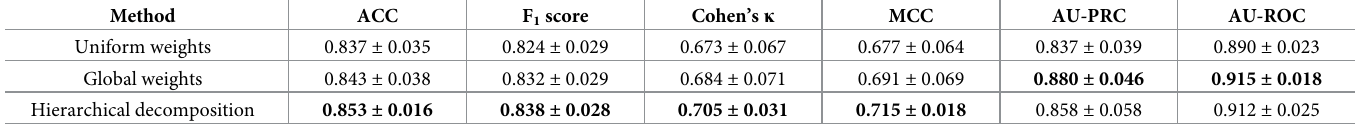
Table 5. Nested cross-validation (outer folds) model performance estimates for each multi-kernel learning method. Uniform weights correspond to the sum of kernel matrices. For global weights, a wrapper method is used to learn the optimal weighted sum of kernel matrices. Hierarchical decomposition learns both localized weights and an optimal weighted sum of subset kernel matrices. The highest mean metric for each method is shown in